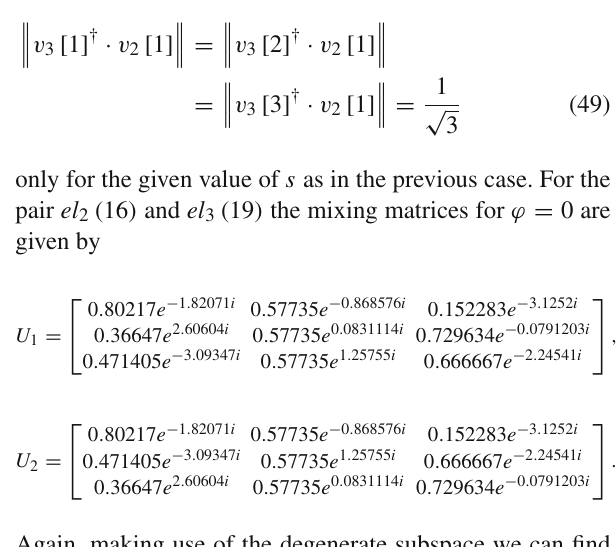
Fig. 1 Case el 2 ( 16 ), el 3 ( 5 ) : the range of sin θ 13 as a function of the angle φ parametrizing the mixing (35) of the degenerate subspace. The orange line defines the upper experimental bound and the blue the lower one on sin θ